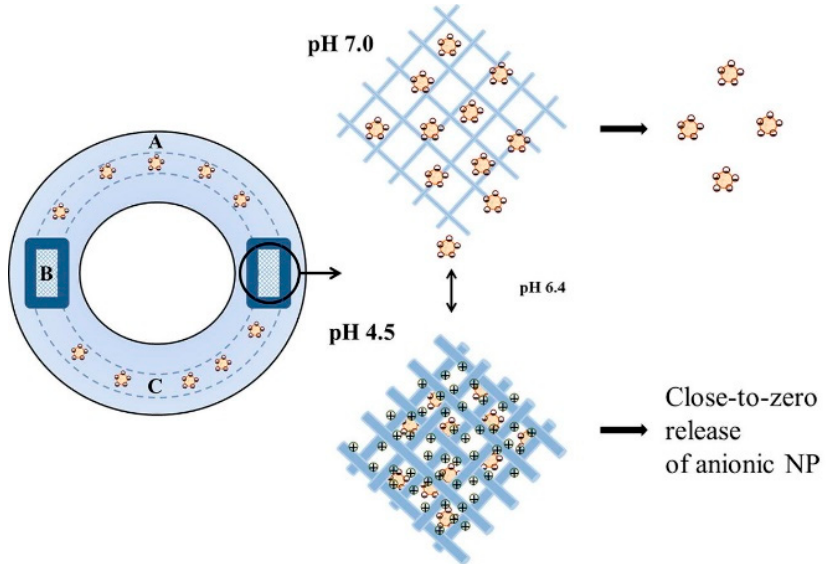
Figure 11. Electrospun PU acts as the membrane controlling drug release from the IVR. At pH 4.5, the PU membrane swells due to the protonation of amine groups in HEP. Due to swelling of the fiber, it blocks the pathway for the drug to be released from the IVR. When pH is increased to 7.0 (after sexual intercourse), the PU fiber shrinks and the drug is released from the IVR’s reservoir. (A) IVR; (B) window membrane; (C) reservoir (Adapted and reprinted with permission from ref. [74] © 2018, Elsevier).